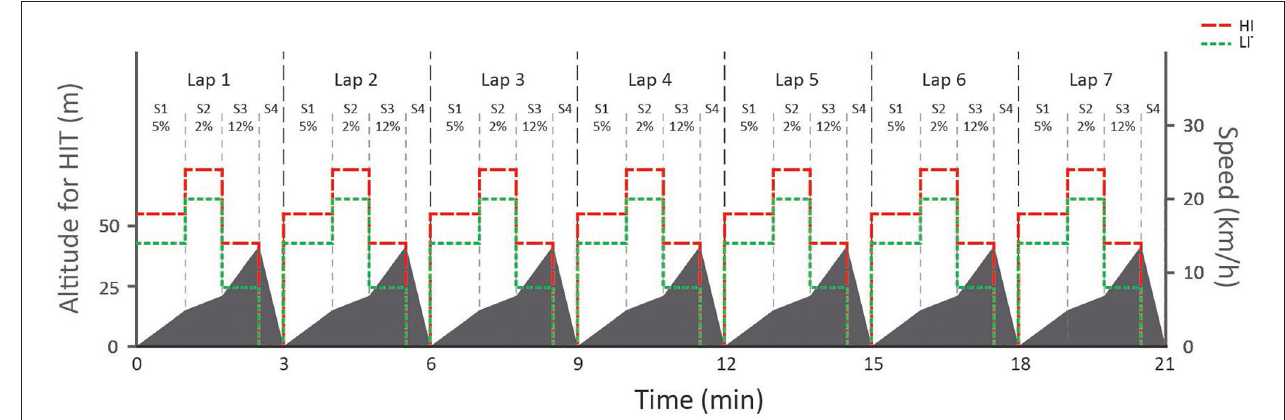
FIGURE 1 | Protocol showing the speed of the treadmill for both the 21min low-intensity (LI) and high-intensity HI sessions and changes in simulated altitude for the HI session. The course was divided into seven 3min laps, each containing four segments (i.e., S1–S4) with the same inclines but different speeds for LI and